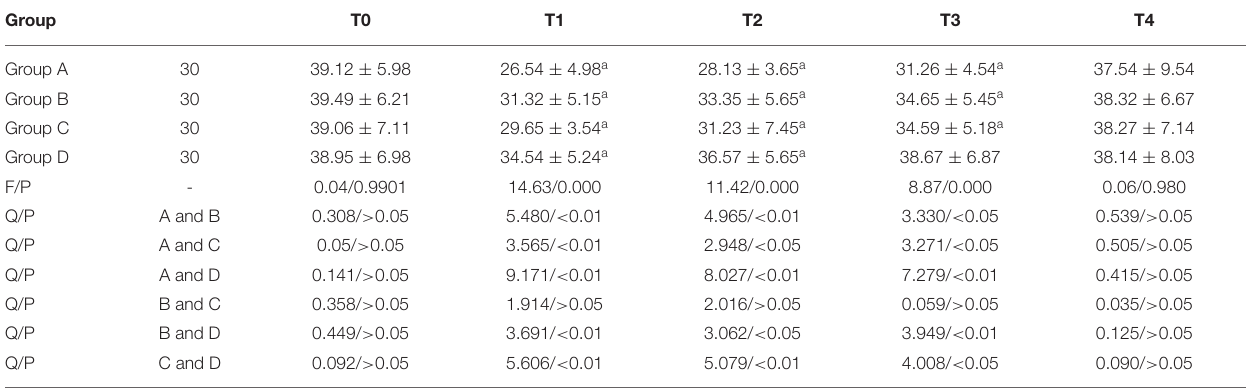
TABLE 2 | Comparison of CD4 + expression among the four groups ( ¯ X ± s).